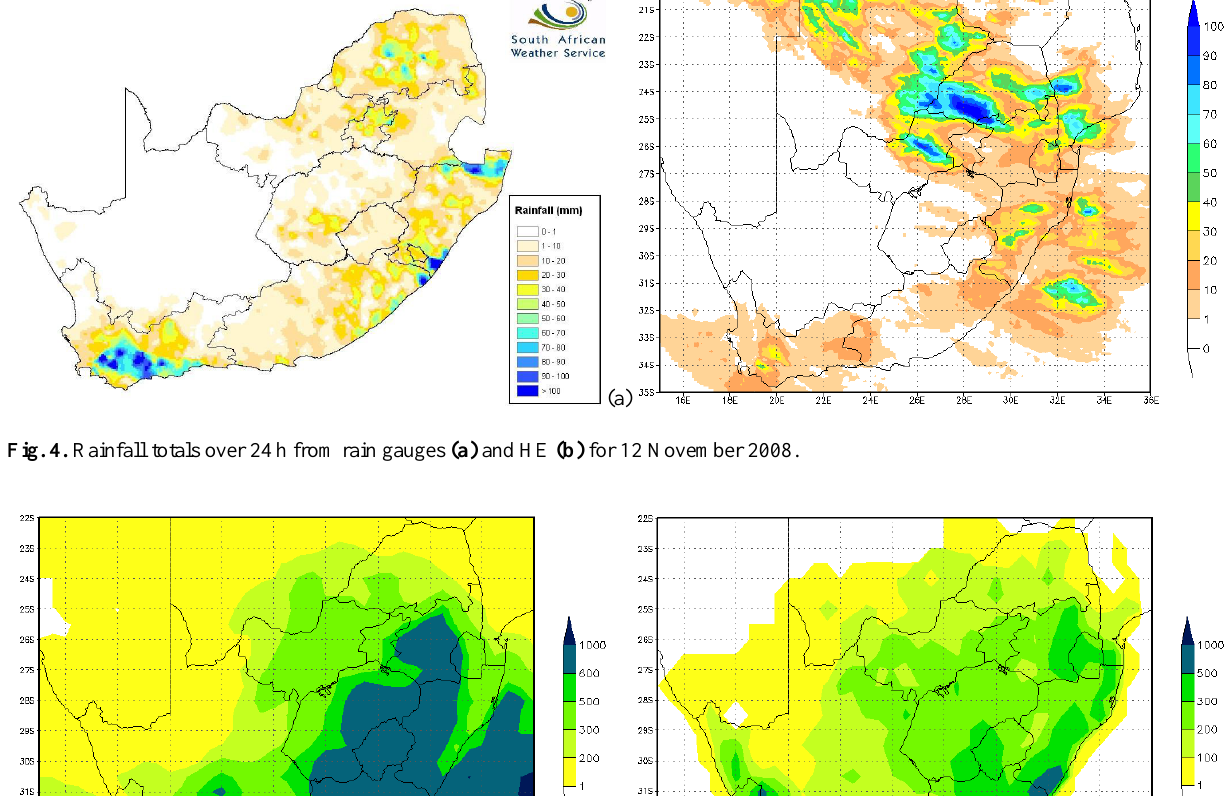
that provide coverage over about two-thirds of the